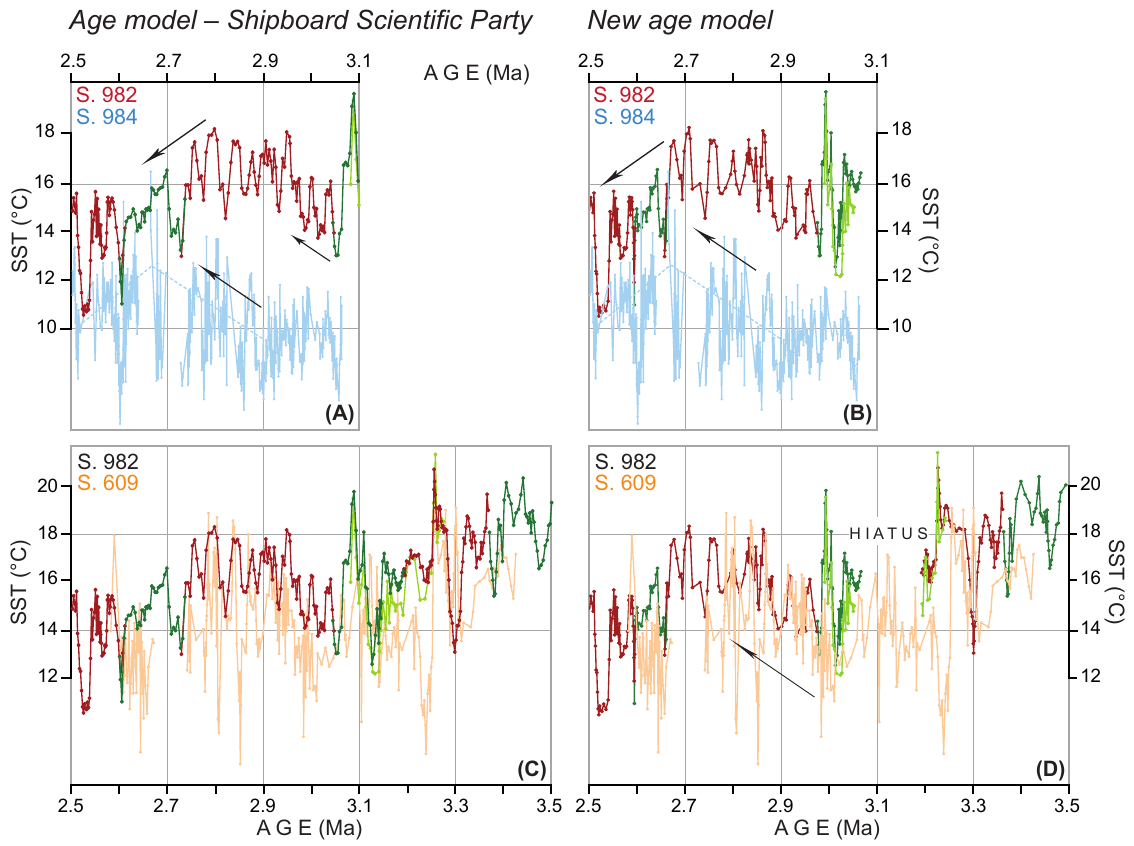
0 Fig. 4. Comparison of U k -based SST records of ODP holes 982A (green and light green) and B (red) (for details see caption of Fig. 3) 37 with Mg/Ca-based SST records analyzed at ODP sites 984 and 609 (Bartoli et al., 2005), plotted both versus the old and new age models discussed in this